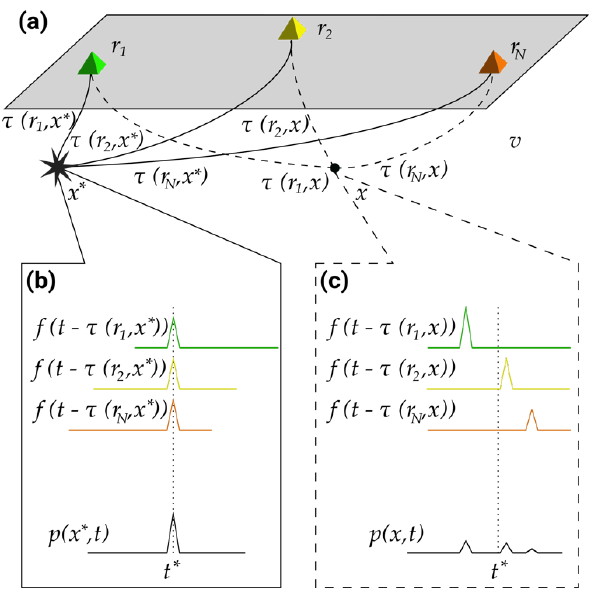
Figure 3. Back-projection general concept: ( a ) a simplified scheme of receivers and travel-times precomputed using ray-bending in the proper velocity model for two points of a study region; ( b ) back-projection to the actual location of the seismic event; ( c ) back-projection to the virtual source point with incorrect travel-times.